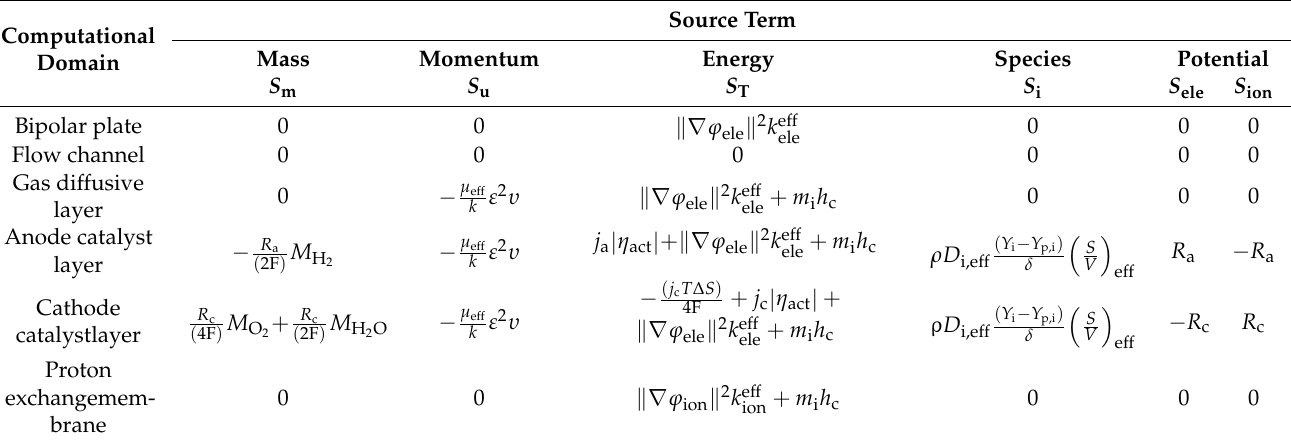
Table 2. Source terms of governing